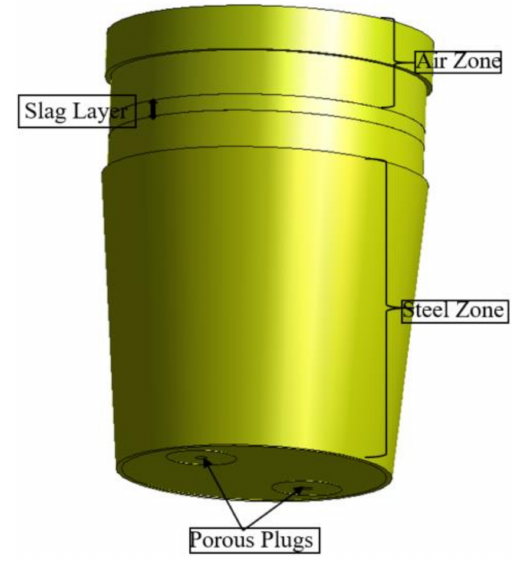
Figure 3. Ladle geometry.